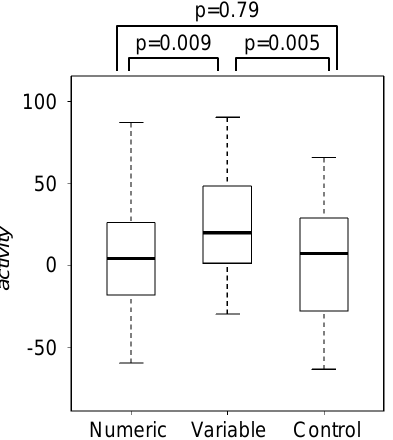
Fig. 12. Evaluation result of the detailed